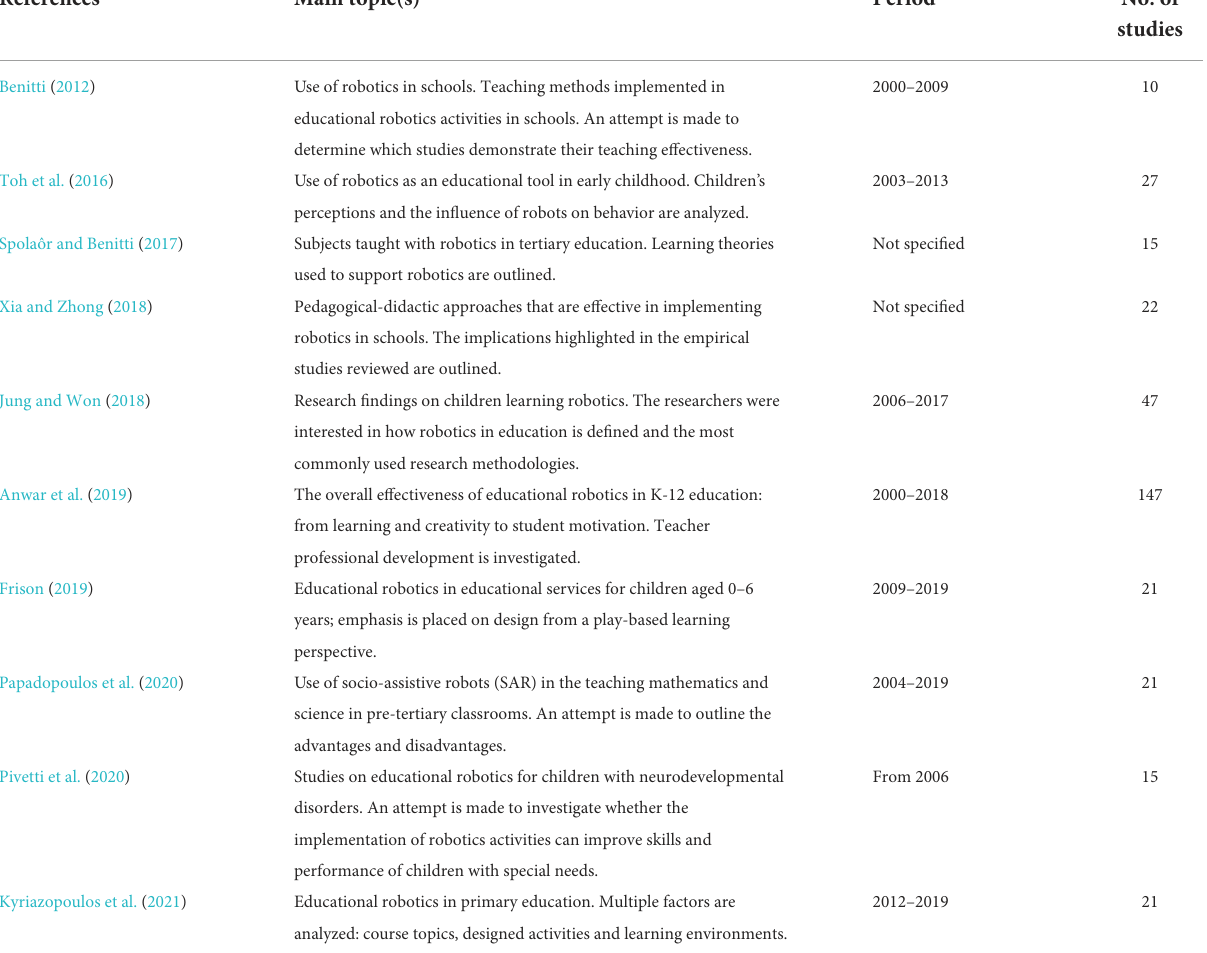
TABLE 1 Systematic reviews of robotics in